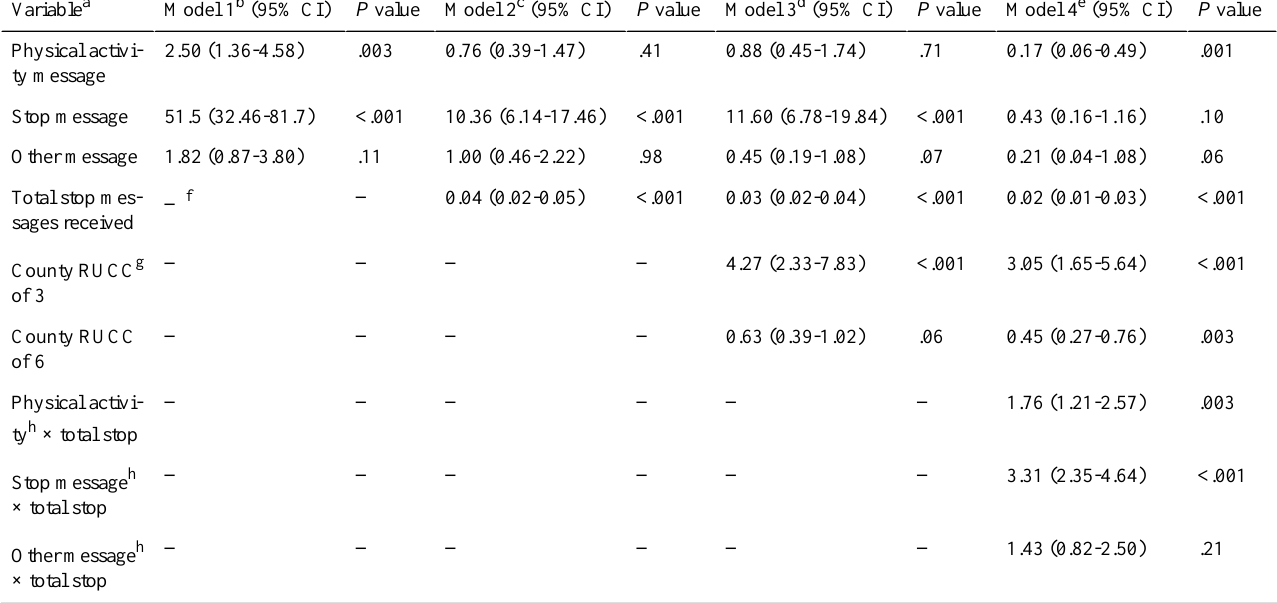
Table 3. Predictors of attrition by message type.